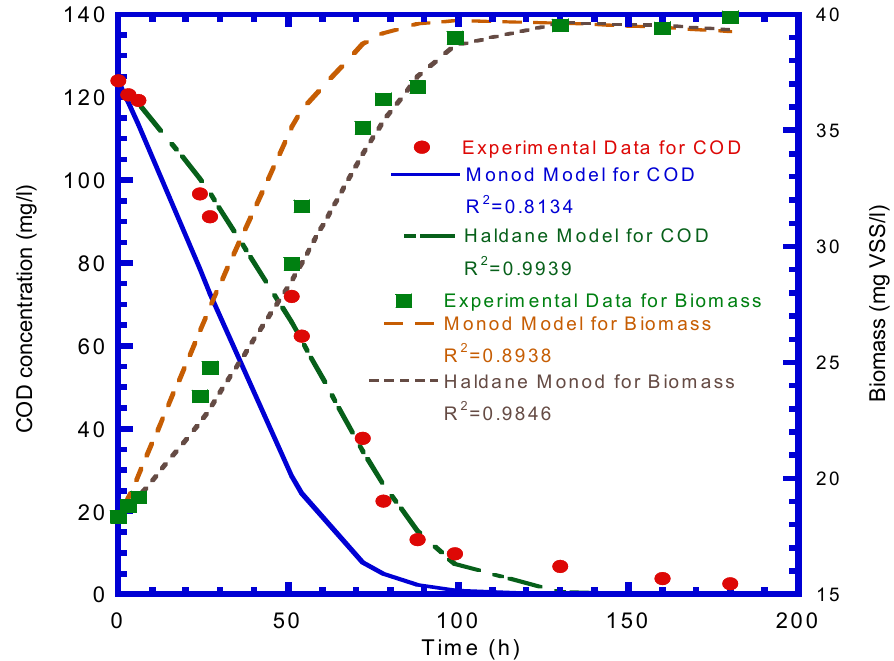
Figure 6. Experimental data were fitted by the Monod and Haldane kinetic models to evaluate the maximum specific utilization rate ( k = 3.52 mg COD/mg VSS–d), half-saturation constant ( K S = 71.7 mg COD/L), inhibition constant ( K i = 81.63 mg COD/L), and death rate coefficient ( k d = 4.9 × 10 –3